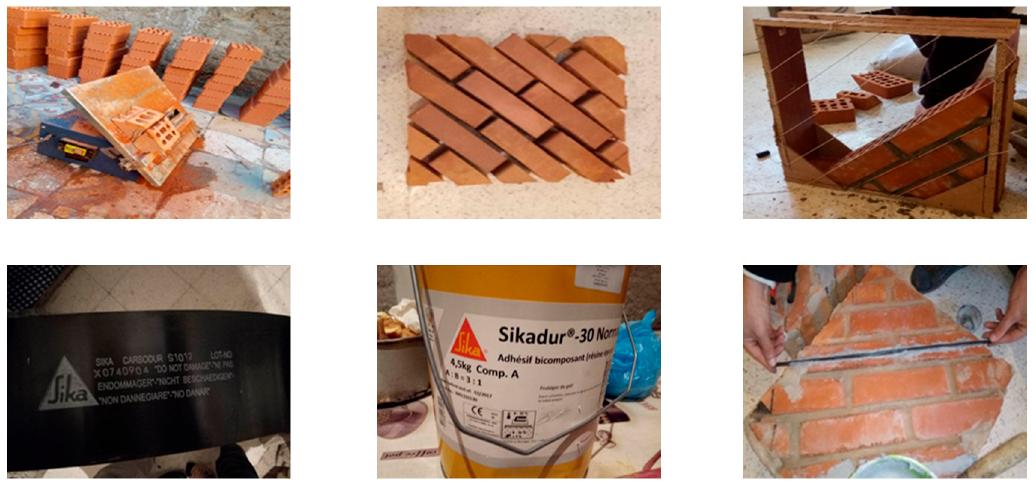
Figure 3. Specimens’ preparation and NSM-CFRP strips installation.